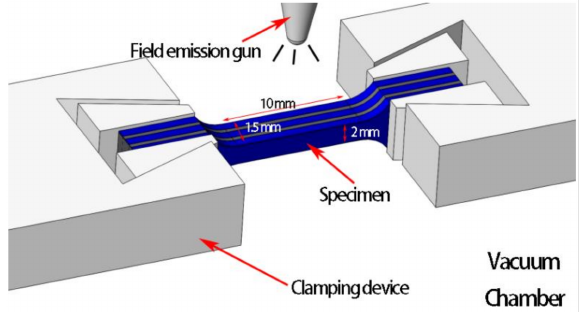
Figure 6. Schematic illustrations of the in-situ tension specimen (unit: